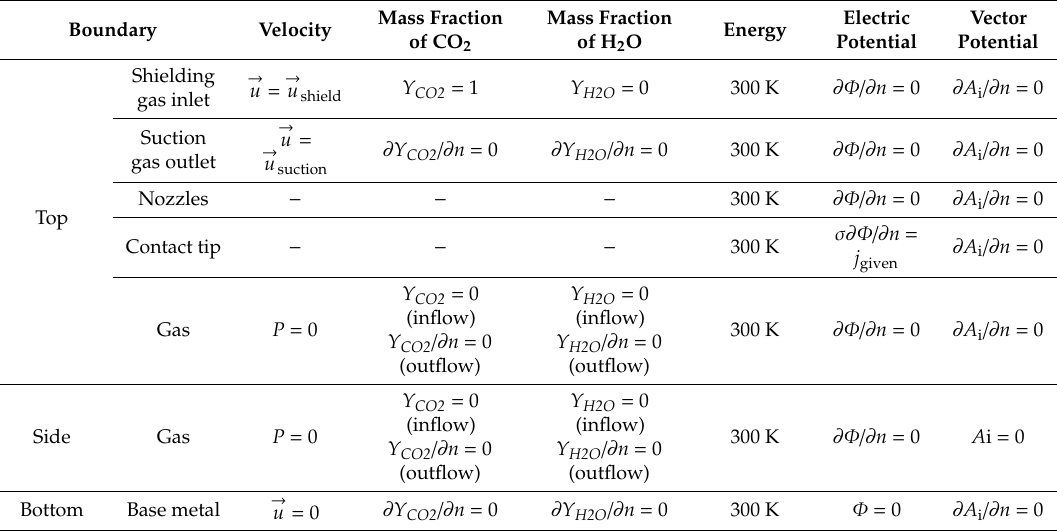
Table 2. Boundary